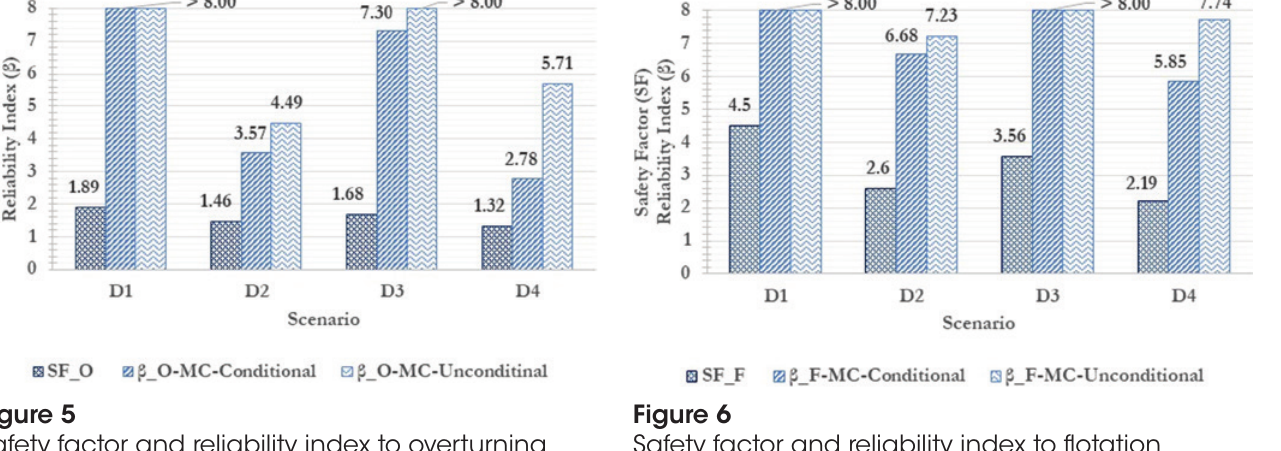
Safety factor and reliability index to flotation failure